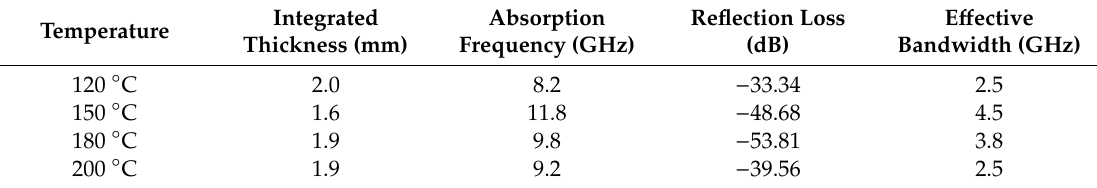
Table 1. Microwave absorption properties of FeCo/ZnO composites at different temperatures (120 °C; 150 °C; 180 °C and 200 °C).